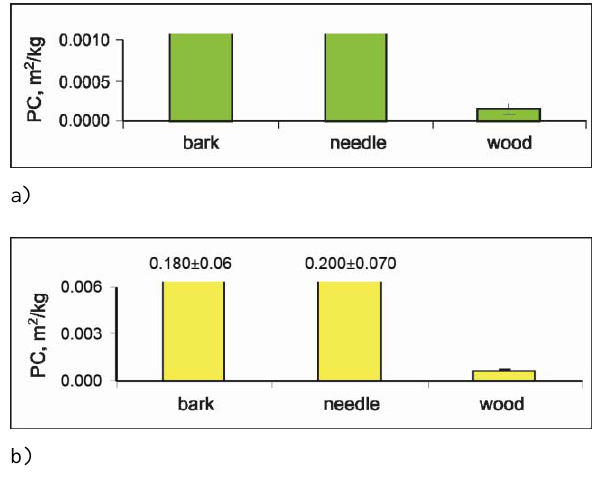
Fig. 5. 90 Sr (a) and 137 Cs (b) transfer coefficients from soil to elements of Scots